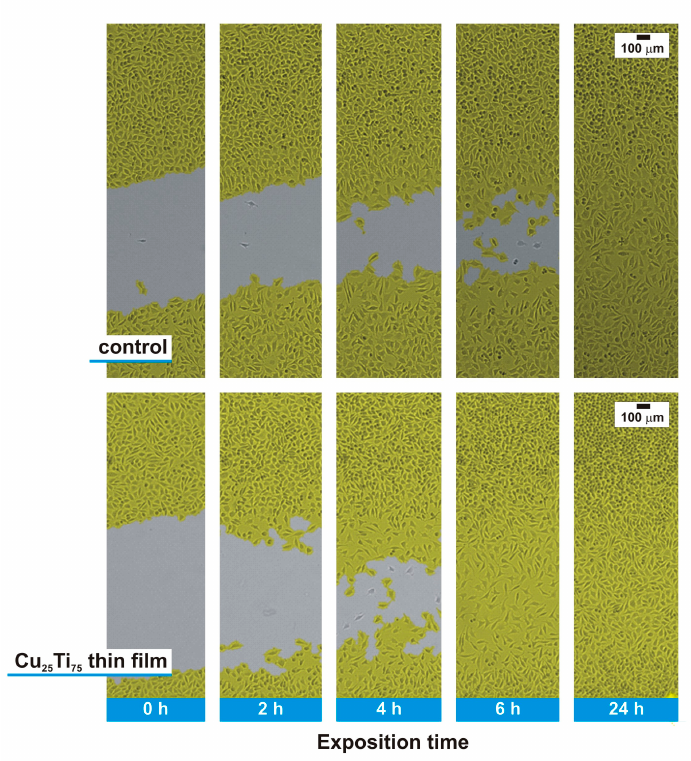
Figure 6. Dynamics of the migration of L929 cells exposed to Cu 25 Ti 75 thin film extracts, compared to an unexposed control. 24 h incubation, microscopic images, 100× magnification.